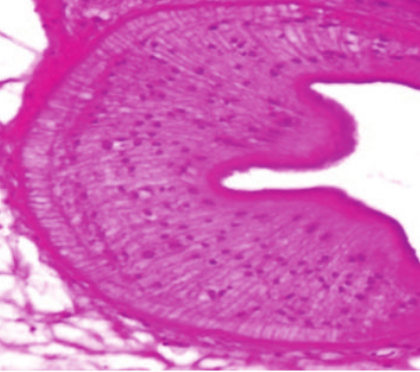
Figure4:Highpowerviewofscolex(haematoxylinandeosin ×